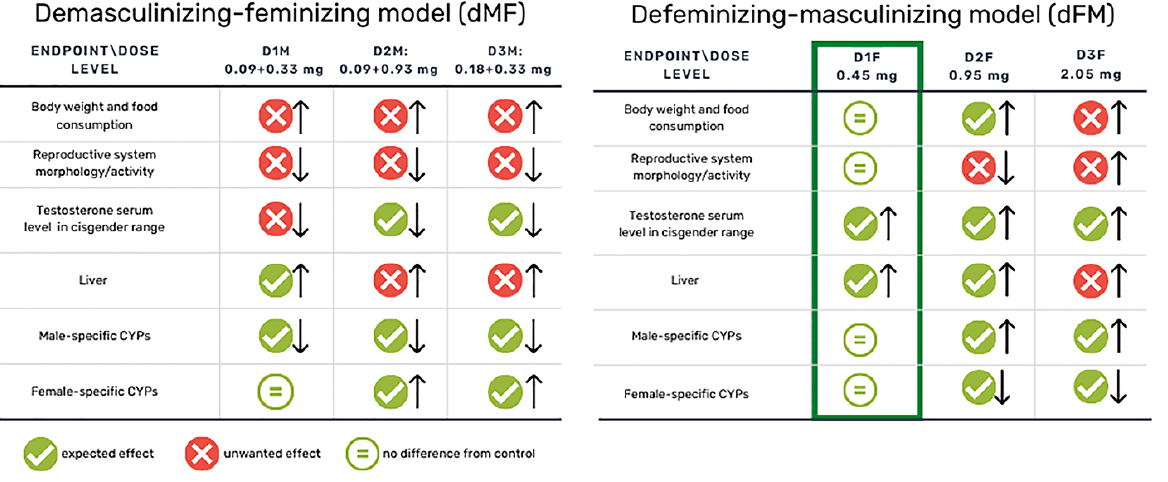
Figure 11. Main ‘solid endpoints’ used to establish the suitable dose for the implementation of the demasculinizing-feminizing (dMF) and defeminizing-masculinizing (dFM) models. Arrows indicate an increasing or decreasing in comparison to controls.